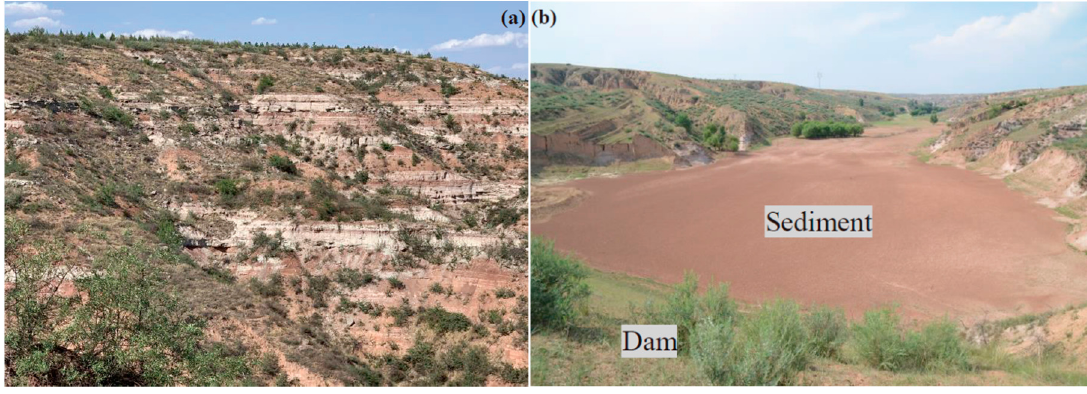
Figure 2. Photos of Pisha sandstone area; ( a ) typical sandstone; ( b ) example of check dam.